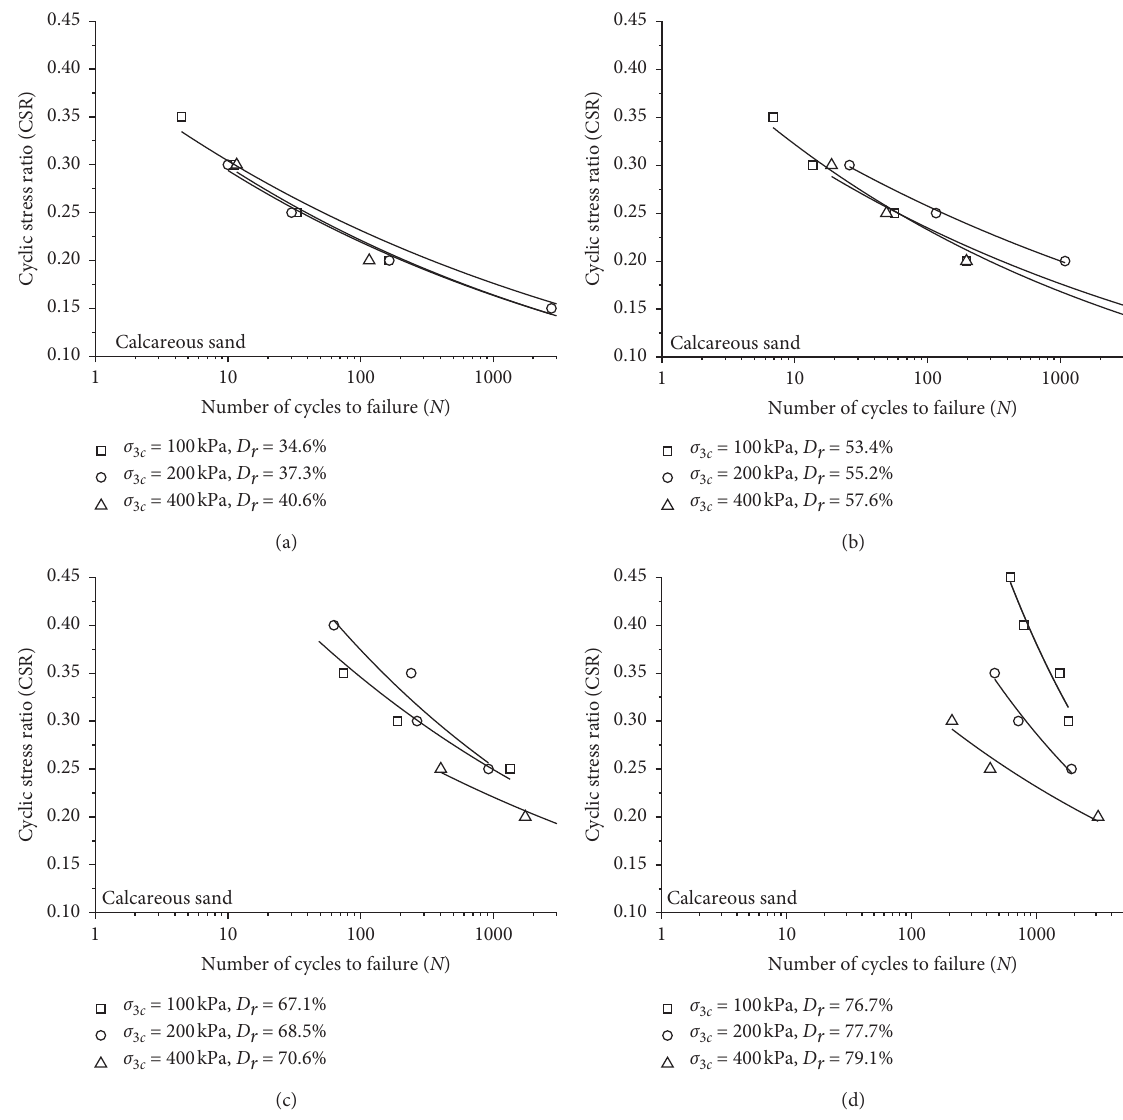
Figure 9: Effect of σ on the cyclic strength curves of calcareous sand. (a) D r � 34.6–40.6%. (b) D r � 53.4–57.6%. (c) D r � 67.1–70.6%. (d) 3 c D r �